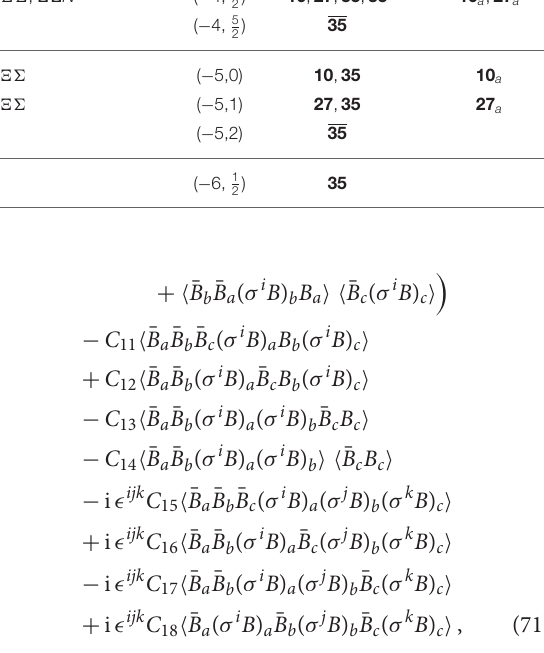
0, and the total angular momentum J =